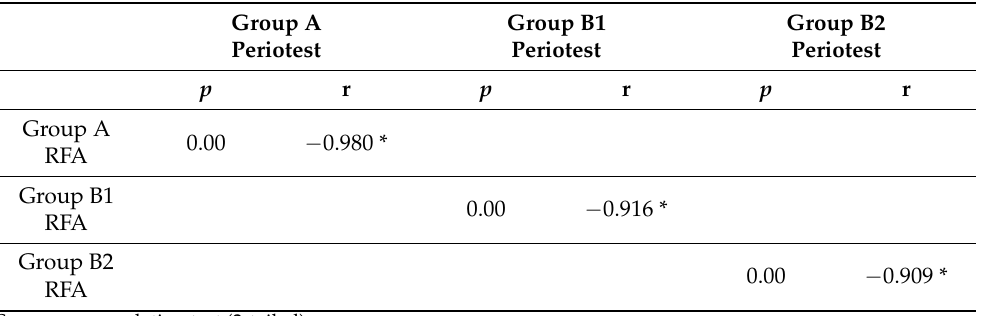
Table 4. Correlation between RFA and Periotest values for all three